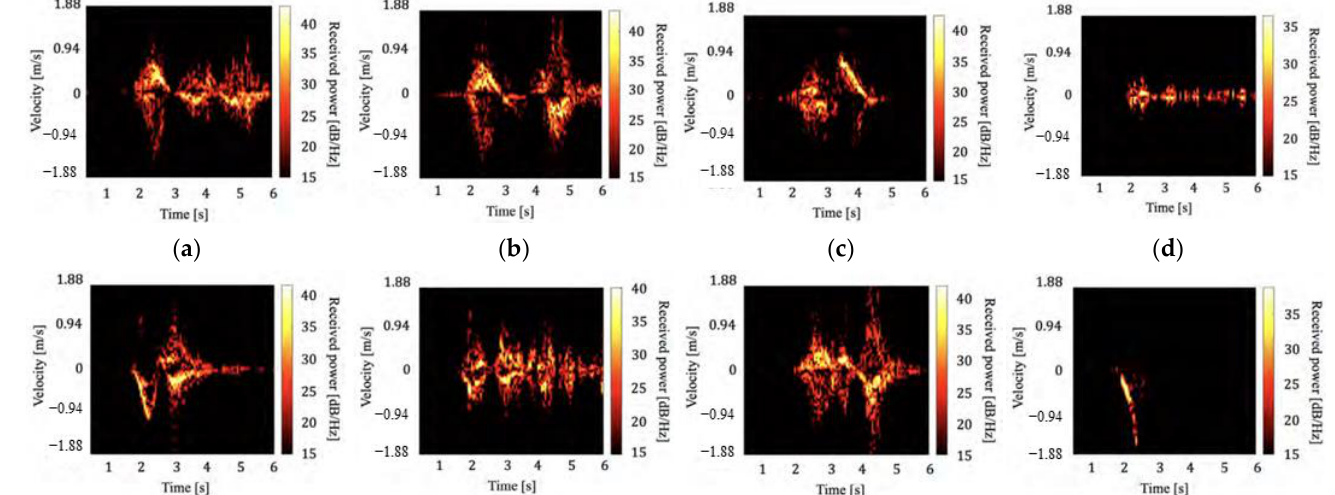
Figure 3. Examples of spectrograms measured with the wall radar. ( a ) Opening the toilet lid, ( b ) pulling down the pants, ( c ) sitting, ( d ) taking the toilet paper, ( e ) standing, ( f ) pulling up the pants, ( g ) closing the toilet lid, and ( h ) falling.